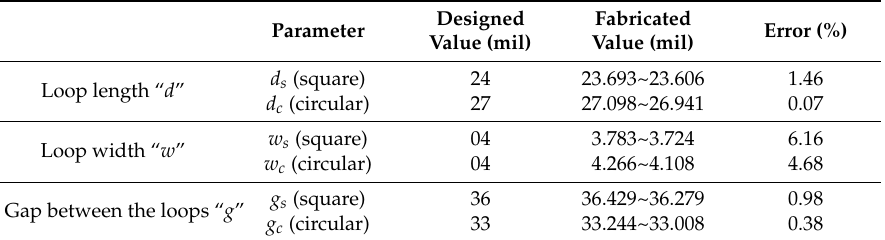
Figure 7. Fabricated FSS filters: ( a ) Square-loop structure, ( b ) Circular-loop structure, ( c ) Fabricated size of the FSS filters is 19.7 × 6.3 inches (500 × 160 mm). Table 1. Comparison of the designed and fabricated parameter